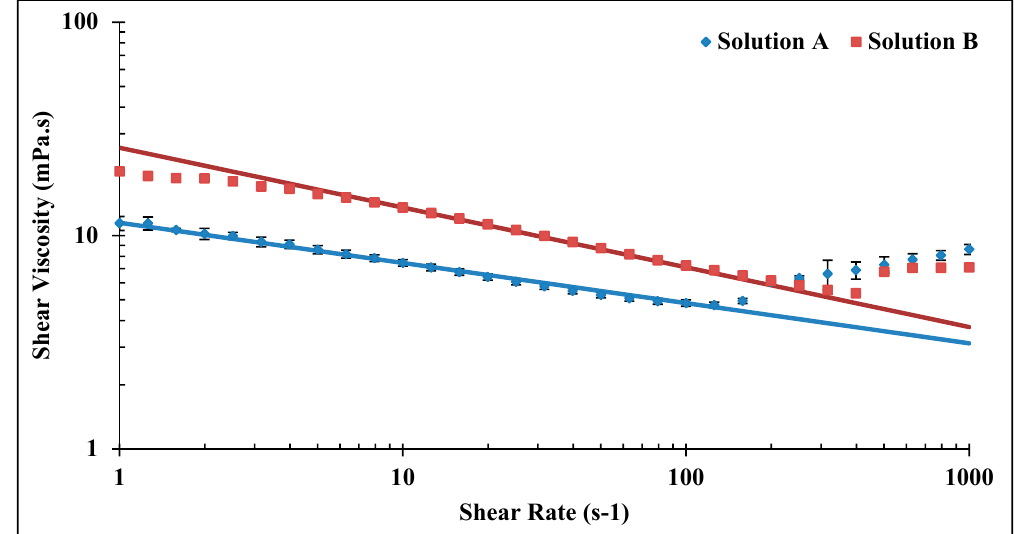
Figure 4. Shear viscosity of bulk Solutions A and B in 1 wt. % NaCl at 22 °C. Solid lines represent power law model. Error bars for Solution B are smaller than the size of each point (±0.20 mPa.s).